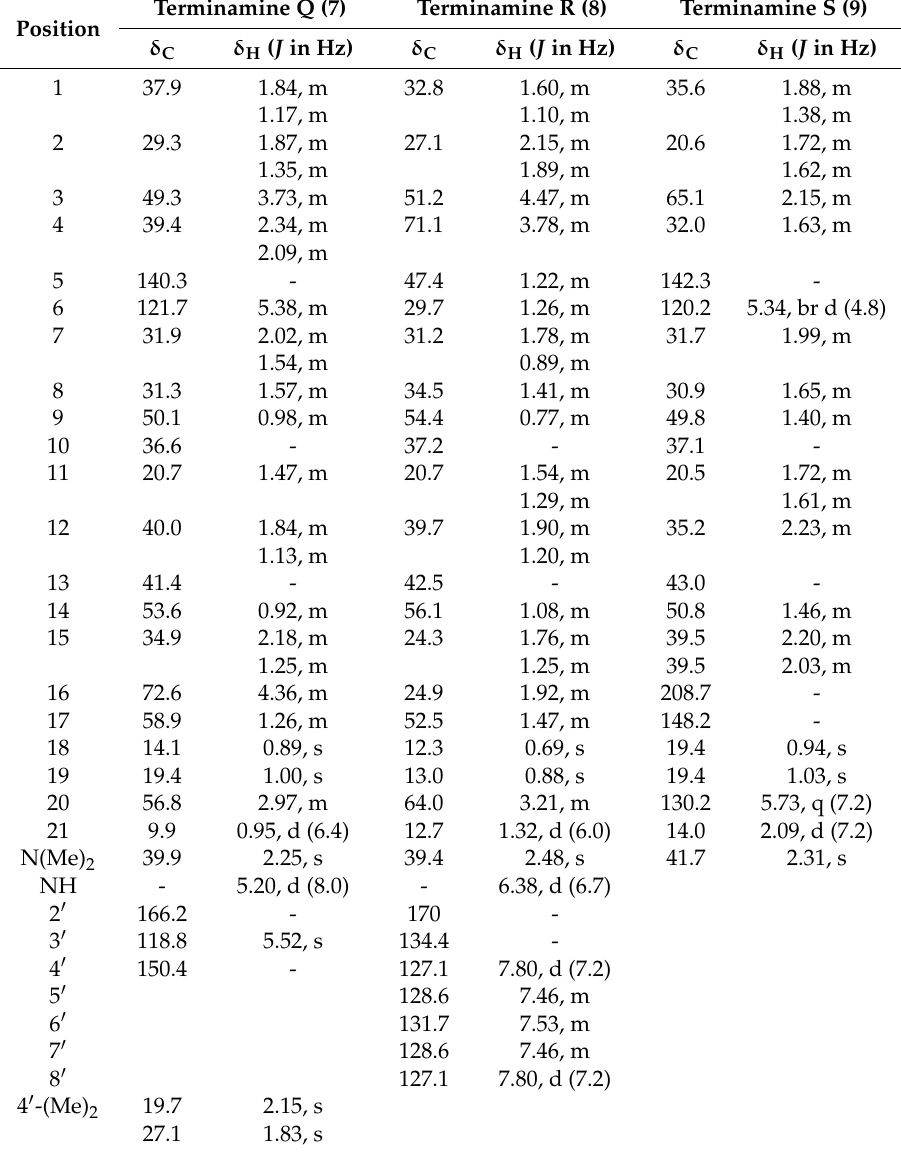
Table 3. NMR Spectroscopic data (400 MHz, CDCl 3 ) for Terminamine Q-S ( 7 – 9